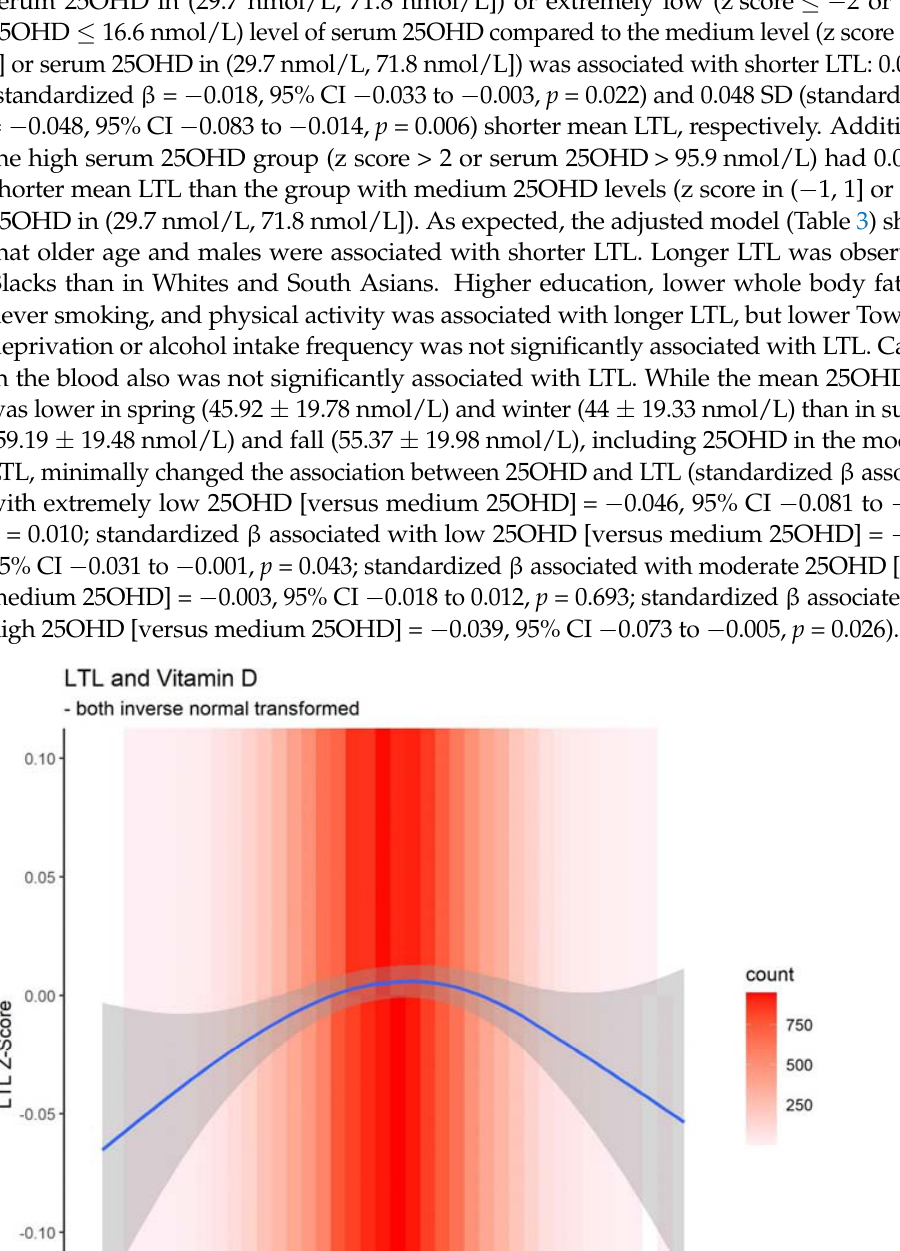
Table 1. Data used to examine the association between leukocyte telomere length(LTL) and serum 25OHD. https://biobank.ndph.ox.ac.uk/showcase/search.cgi (accessed on 17 March,2023).